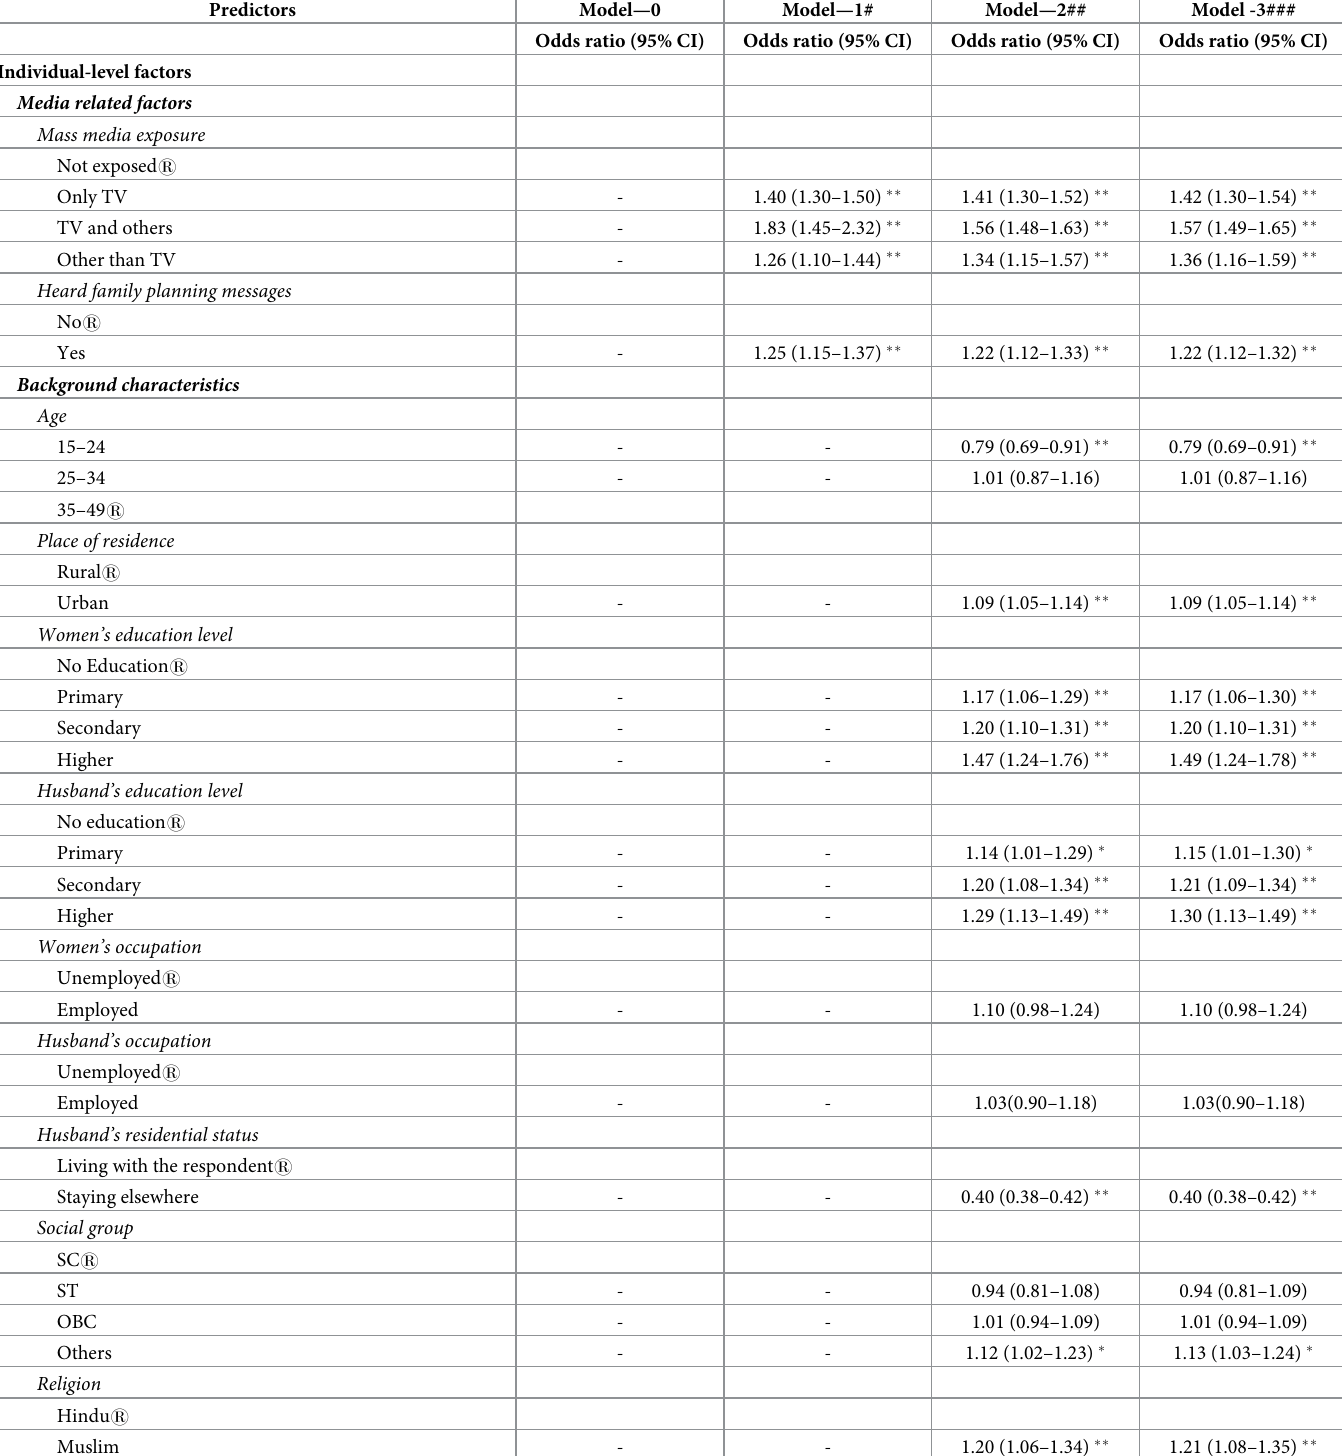
Table 5. Multilevel logistic regression analysis showing odds ratio and 95% confidence interval (CI) for family planning method use among those currently using any reversible modern method for all married women aged 15–49 years in India (N = 237505), NFHS